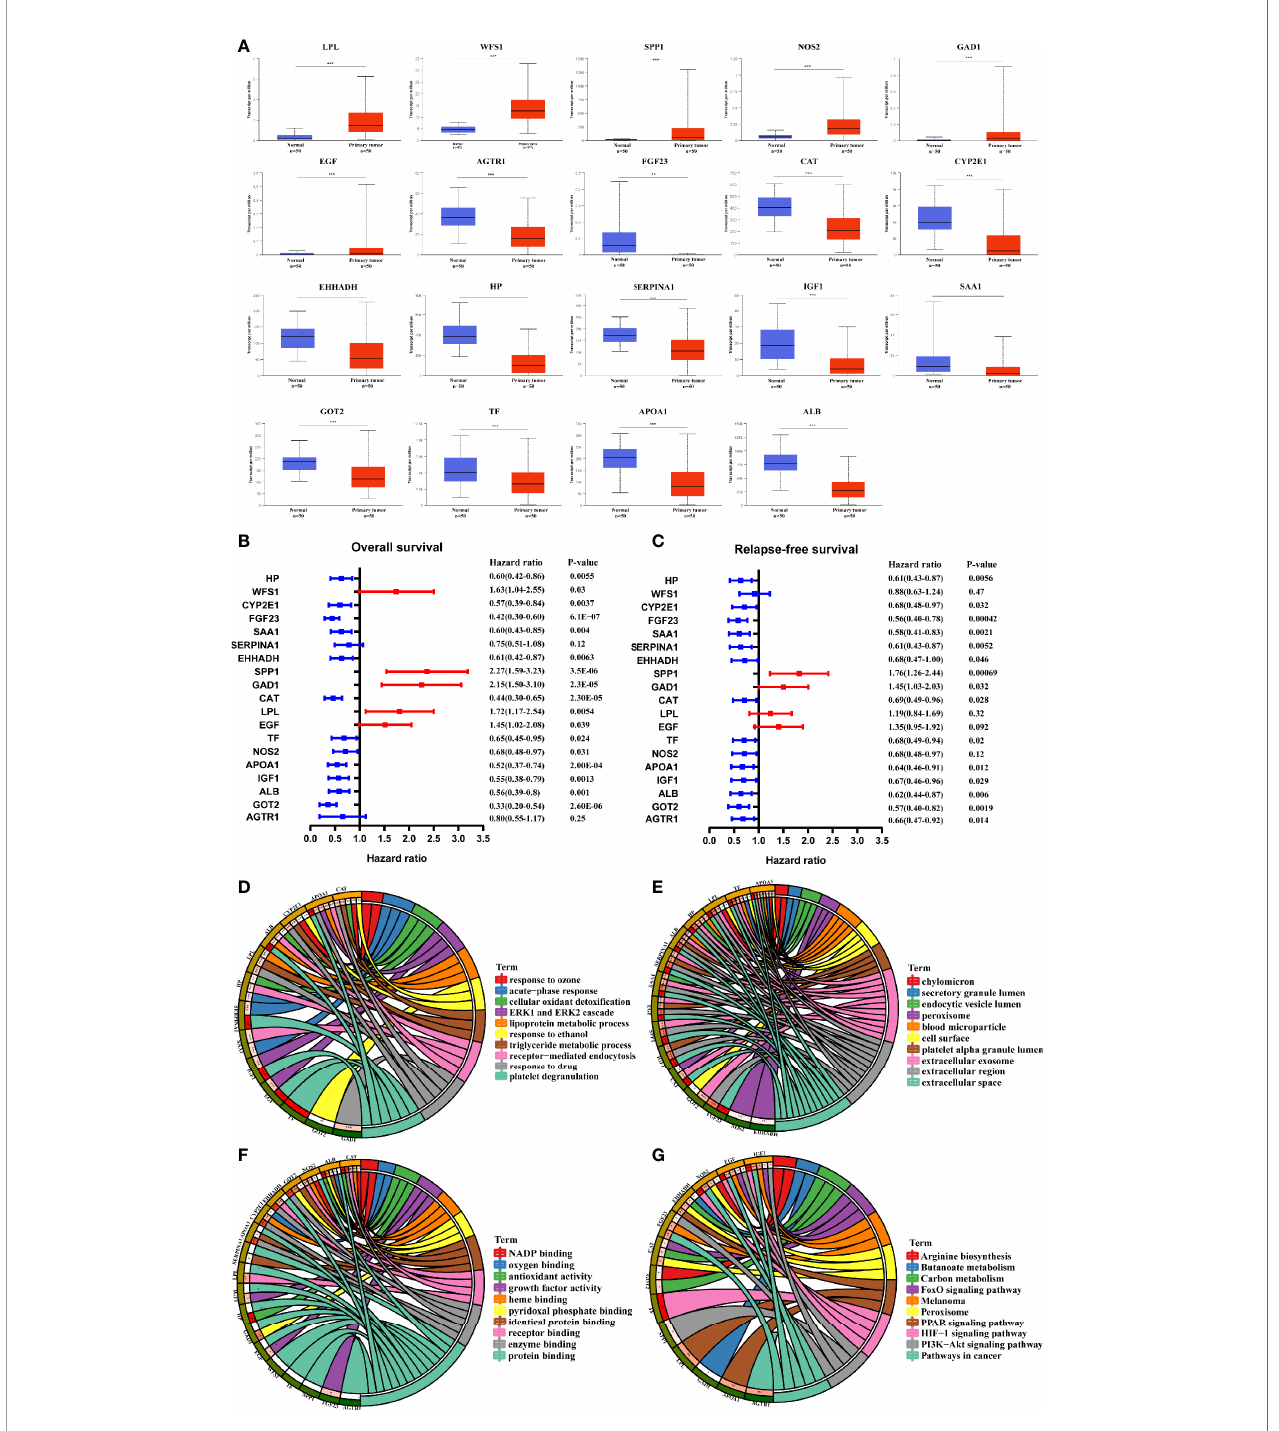
FIGURE 3 | Validation of the expression and prognosis analysis of hub MRGs in HCC and their function enrichment. (A) UALCAN analysis of 21 DE-MRGs based on the TCGA database. *P < 0.05; **P < 0.01; ***P < 0.00001. (B, C) Forest plot of the univariate Cox regression analysis of OS and RFS with MRGs. P ≤ 0.05 was considered statistically signi fi cant. (D) Chord plot describing the relationship between 19 hub MRGs and GO terms of BP. (E) Chord plot depicting the relationship between 19 hub MRGs and GO terms of CC. (F) Chord plot showing the relationship between 19 hub MRGs and GO terms of MF. (G) Chord plot showing the relationship between 19 hub MRGs and KEGG